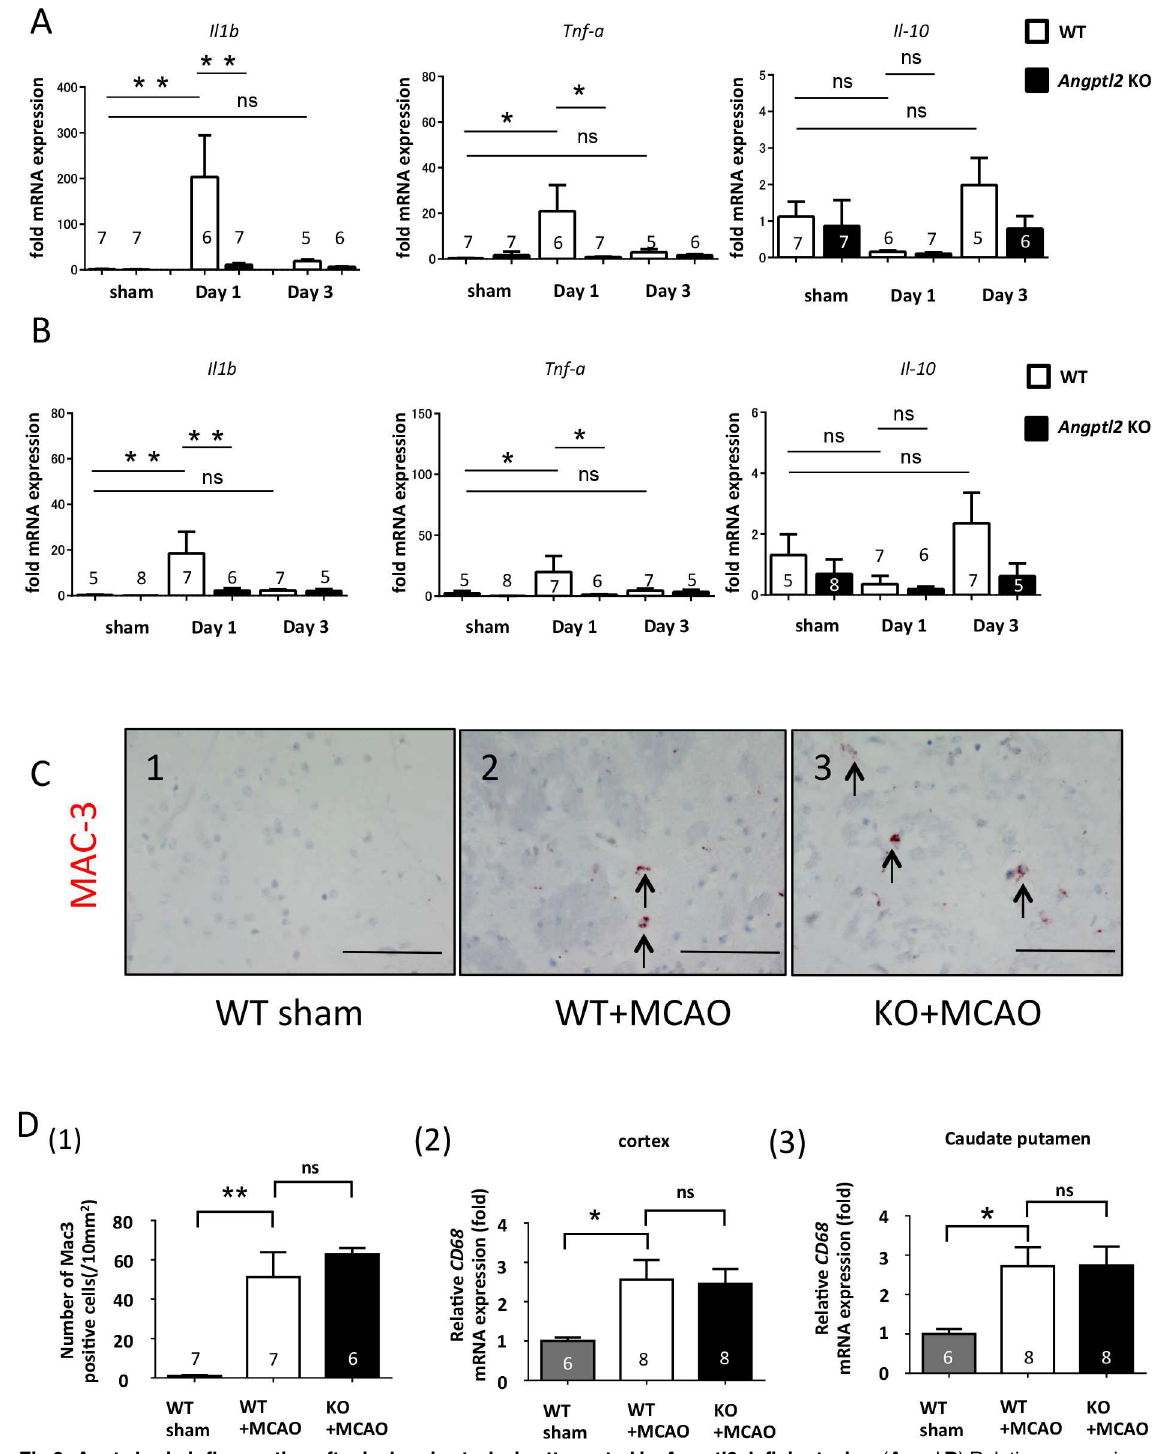
Fig 3. Acute brain inflammation after ischemic stroke is attenuated in Angptl2 -deficient mice. ( A and B ) Relativeexpression of Il1b , Tnfa , and Il10 mRNAs in cortex (sham: WT = 7 and KO = 7; day 1: WT = 6 and KO = 7; day 3: WT = 5 and KO = 6) ( A ) and ipsilateral caudate putamen(sham: WT = 5 and KO = 8; day 1: WT = 7 and KO = 6; day 3: WT = 7 and KO = 5) ( B ). mRNA levels were normalizedto those of T bp . Values are expressedas fold-increasesrelative to values in WT, which were set at “1” in each case. ( C ) Representative images showingMAC-3 immunostaining in the ipsilateralcerebralhemisphere 24 hours after sham or